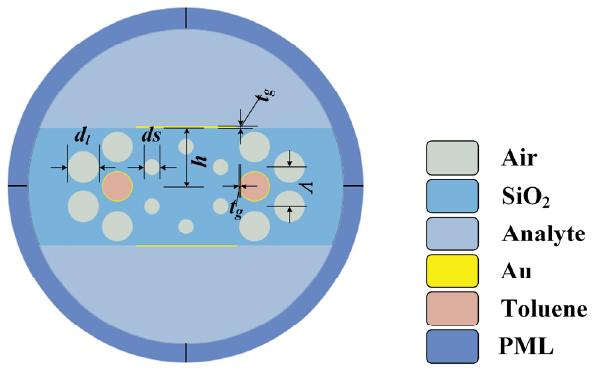
Figure 1. Schematic diagram of the proposed flat PCF-SPR sensor.